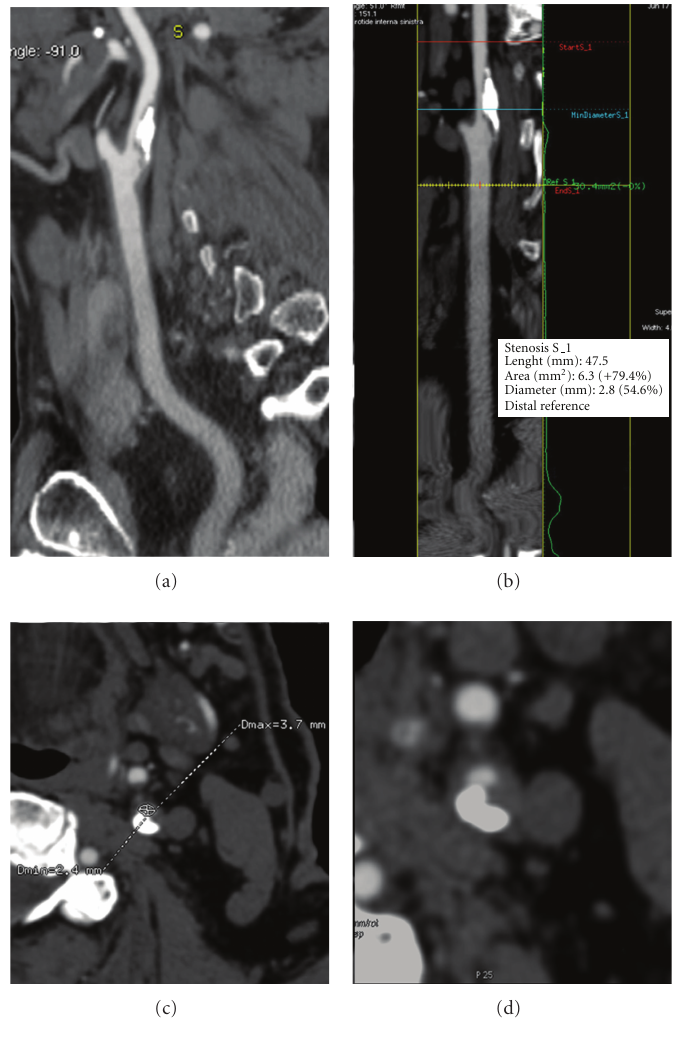
Figure 3: Left carotid stenosis demonstrated on CT angiography (CTA) (Case 1) with curved image (a) and lumen image produced by advanced vessel analysis (AVA) software (b). The curved image shows the plaque. The software analysis defines automatically the level of maximal stenosis. (c) regular cross-sectional image with the largest/smallest luminal diameter at the stenosis level. In this case the measurements on CTA show a minimum diameter of 2,4 mm with a 79% of stenosis degree. (d) Axial amage of left carotid